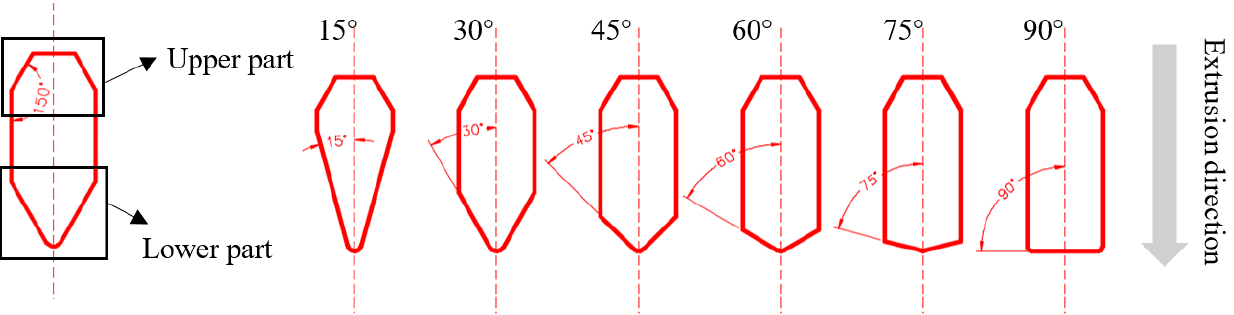
Figure 2. Series of schematics showing the range of lower bridge angles used for each simulation (far left pointed and far right blunt).